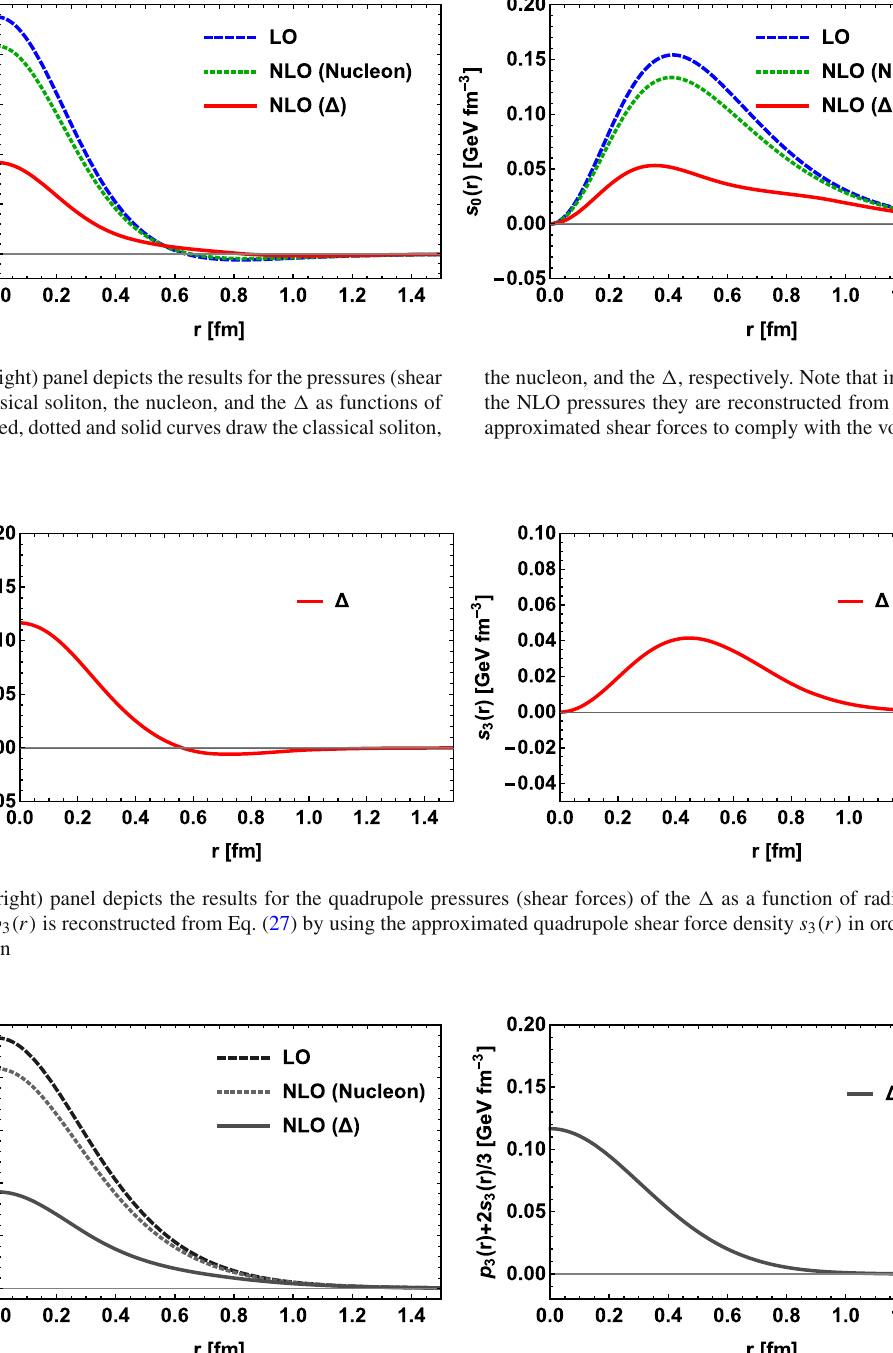
the result for the quadrupole normal force p 3 ( r ) | reconst + 2 NLO and quadrupole pressure densities are reconstructed from Eq. (27) by using the approximated shear force densities s 0 ( r ) and s 3 ( r ) in order to comply with the von Laue